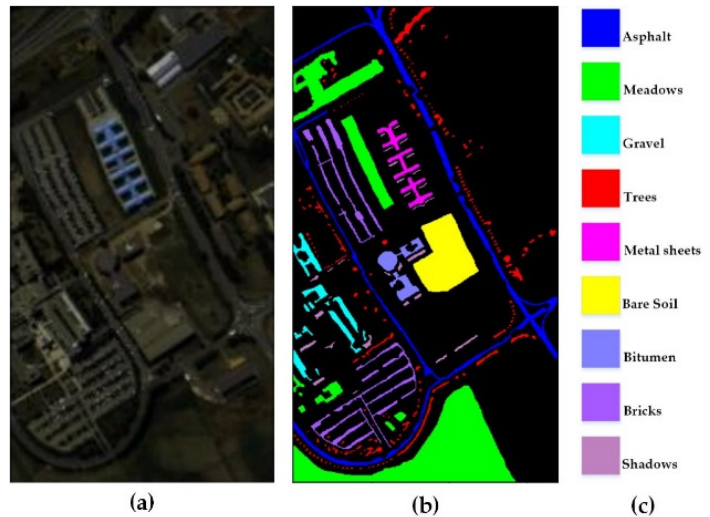
Figure 7. The UP dataset. ( a ) False-color image, ( b ) Ground-truth image, ( c ) Labels.